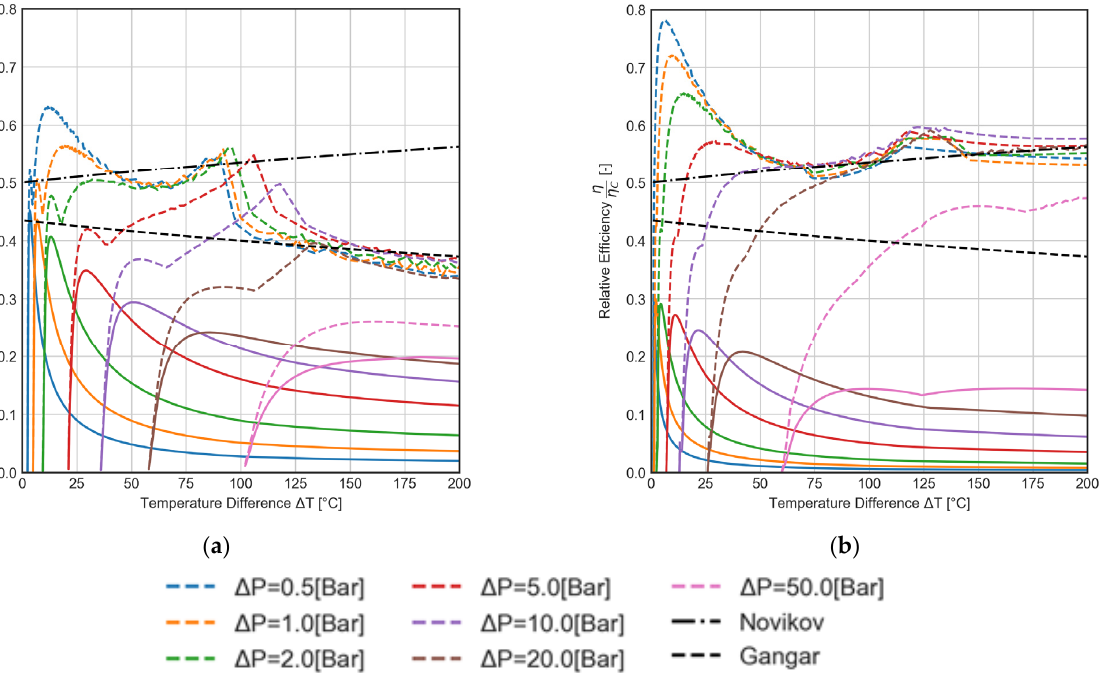
Figure 7. Specific efficiency calculation for 65/35 wt.% ammonia/water ( T L = 30 ◦ C, P L = 6.0 bar) ( a ) and 60/40 wt.% CO 2 /acetone system ( T L = 30 ◦ C, P L = 35.62 bar) ( b ). Solid line = without heat regeneration, dashed line = with heat regeneration.